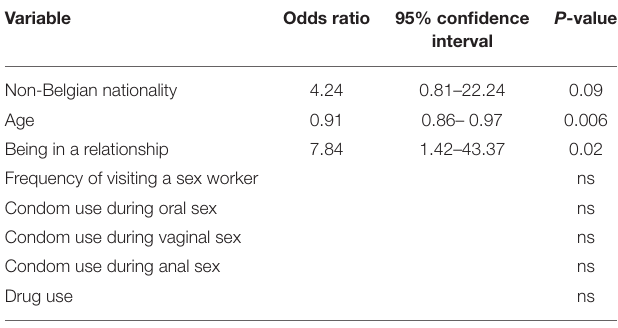
TABLE 4 | Multivariate analysis with STI-test result as dependent